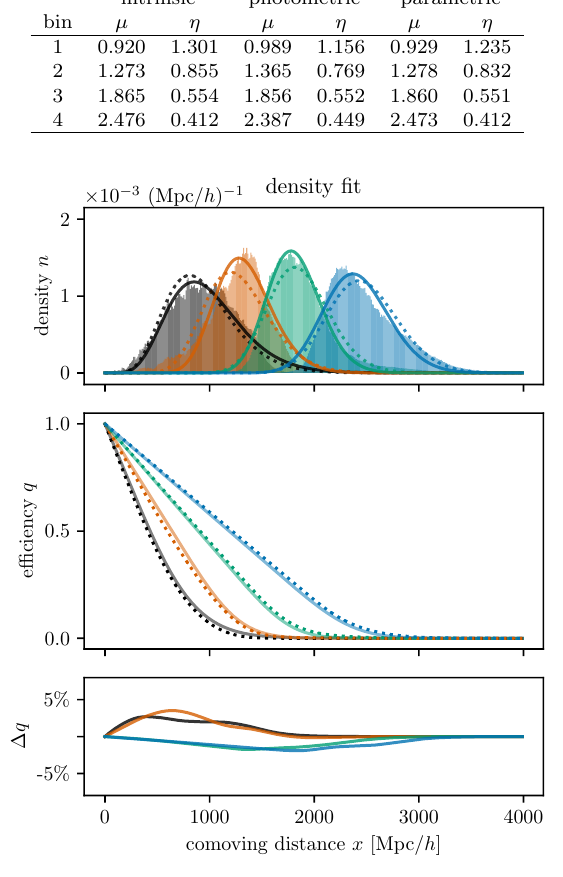
Figure 6. Top: Best-fit densities ( solid ) and densities for the parametric efficiencies ( dotted ). Middle: Lensing efficiencies for the best-fit densities ( solid ) and intrinsic efficiencies ( dotted ). Bot- tom: Absolute difference ∆ q ( x ) between efficiencies for the best-fit densities and intrinsic efficiencies.